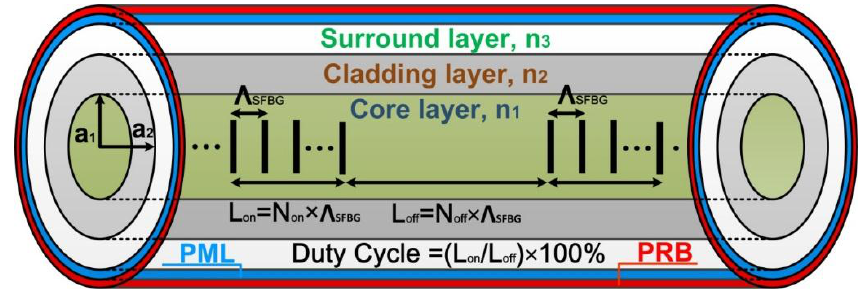
Figure 1. Three-dimensional geometric structure of an SFBG.